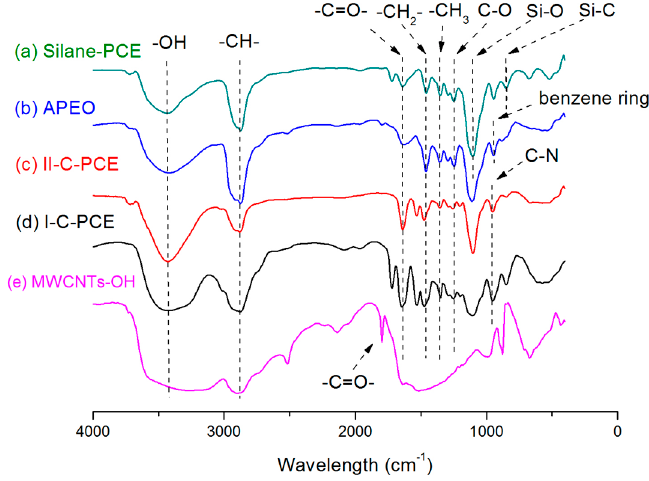
Figure 3. Fourier Transform Infrared Spectrometer (FTIR) spectra of MWCNTs–OH and four surfactants.